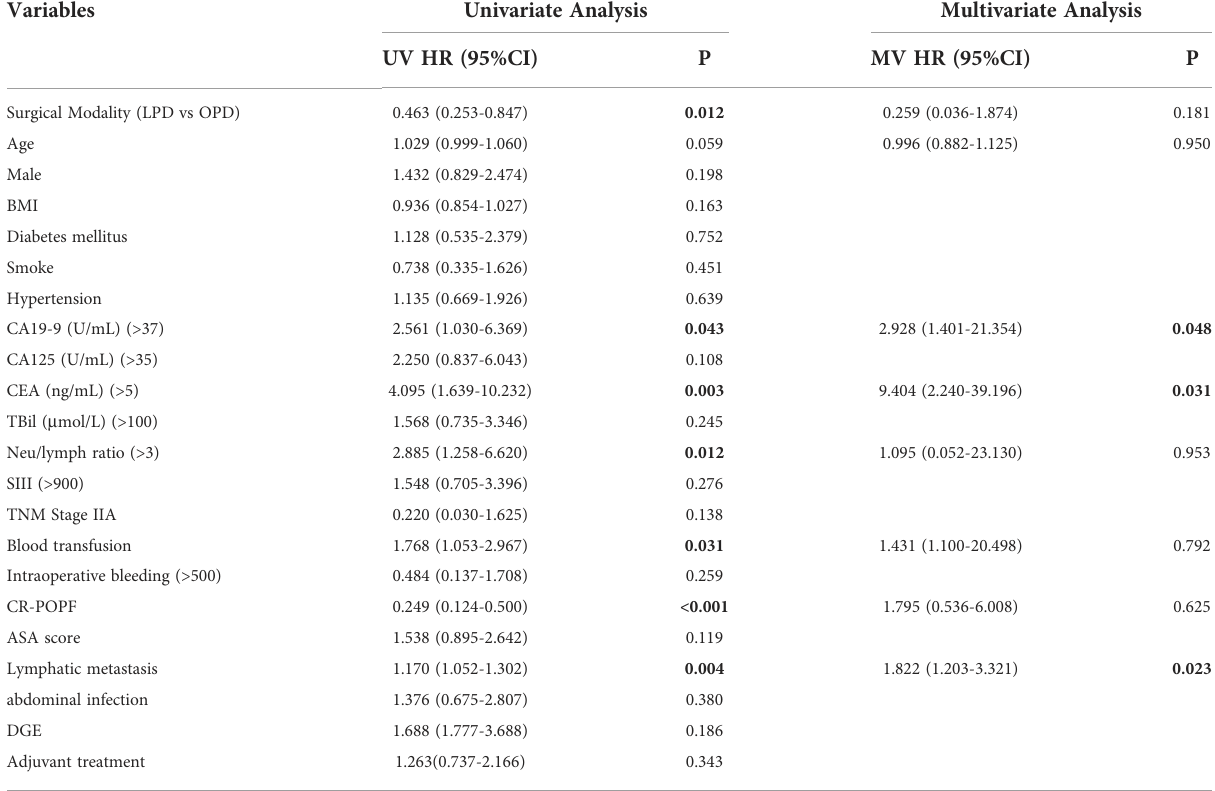
TABLE 3 Independent prognostic factors of OS by Cox-regression analysis of the whole cohort before and after the PSM.